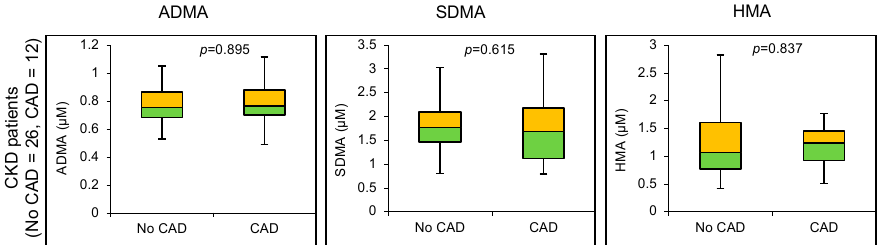
Figure 1. Arginine metabolite levels in CKD patients with and without coronary artery disease (CAD).